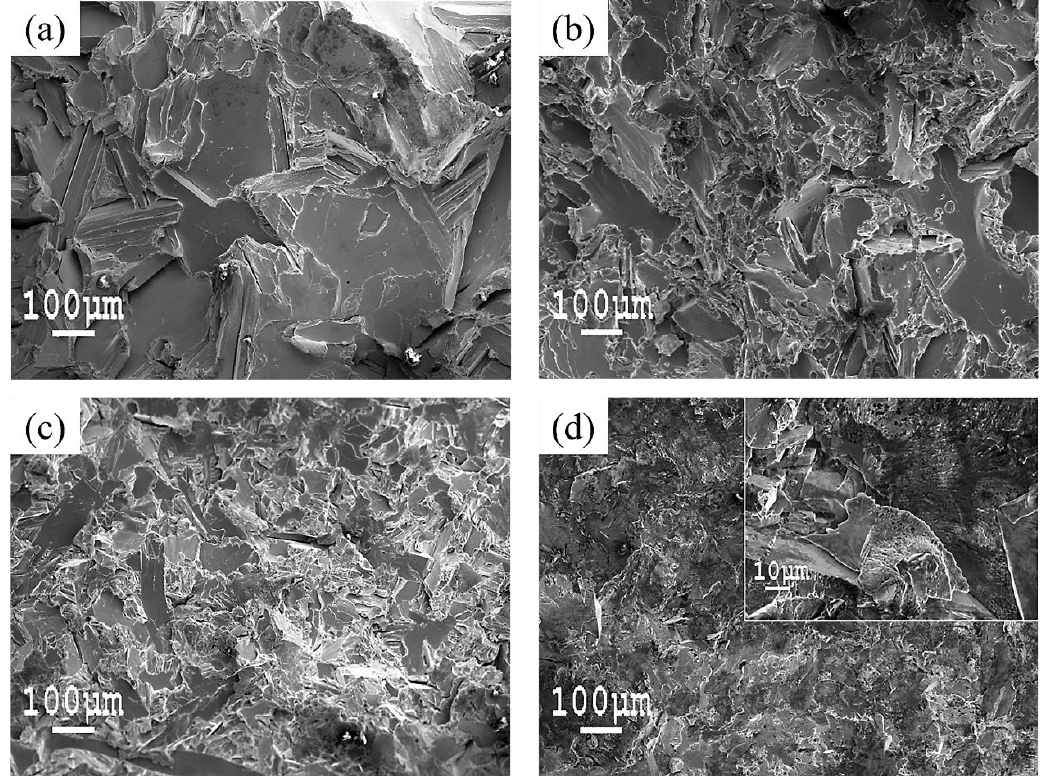
Figure 4. Fracture surfaces of the alloys after tensile tests: ( a ) Cast Zn, ( b ) Zn1Fe0.5Mg, ( c ) Zn1Fe1Mg, ( d ) Zn1Fe-1.5Mg.